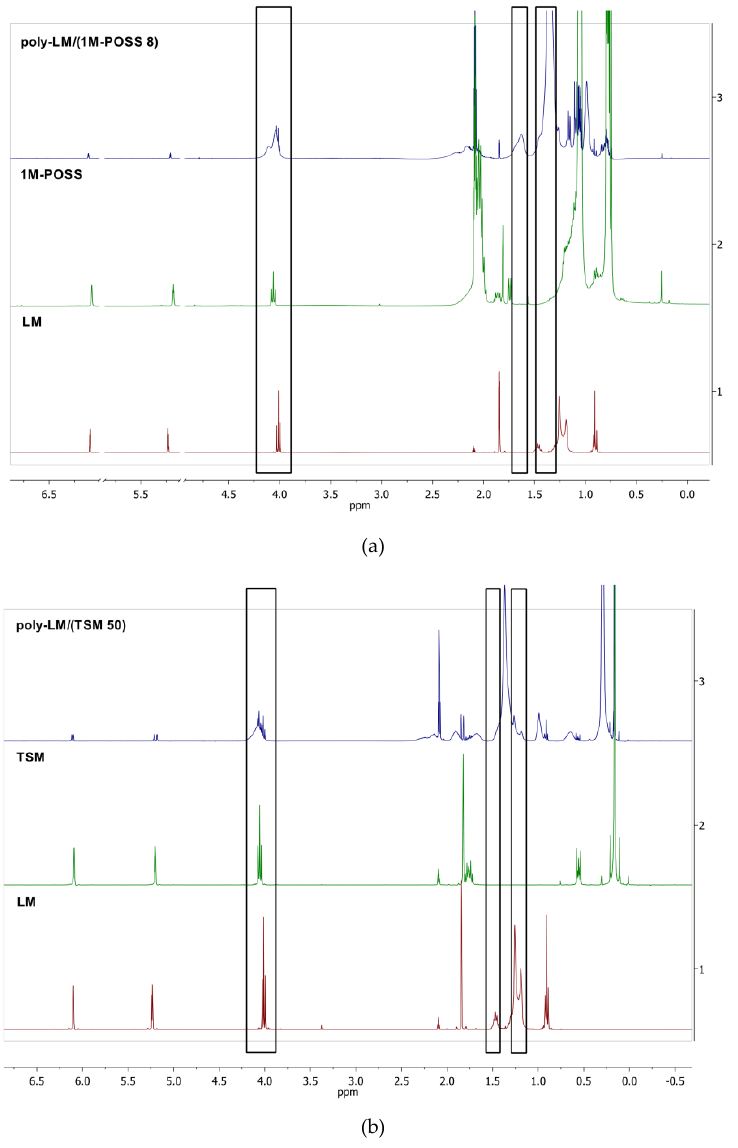
Figure 3. 1 H NMR stacked spectra of the LM monomer, the modifiers, and the copolymers containing ( a ) 8 mol % of 1-M POSS, ( b ) 50 mol % of TSM.